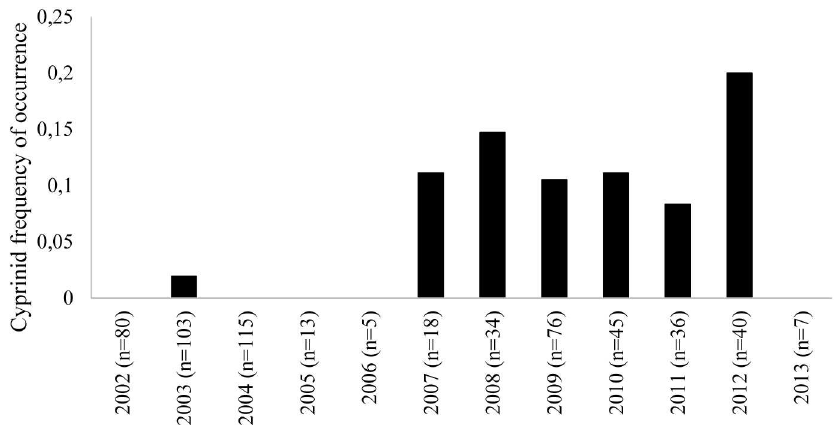
Fig 6. The frequency of cyprinid occurrence in the gastrointestinal contents of grey seals ( Halichoerus grypus ) collected from the Baltic Sea from 2002 to 2013. Annual frequencieswere calculated by dividingthe number of seals containingremnants of cyprinid fish by the total number of seals containingprey items per year. Sample sizes per year are shown in brackets.